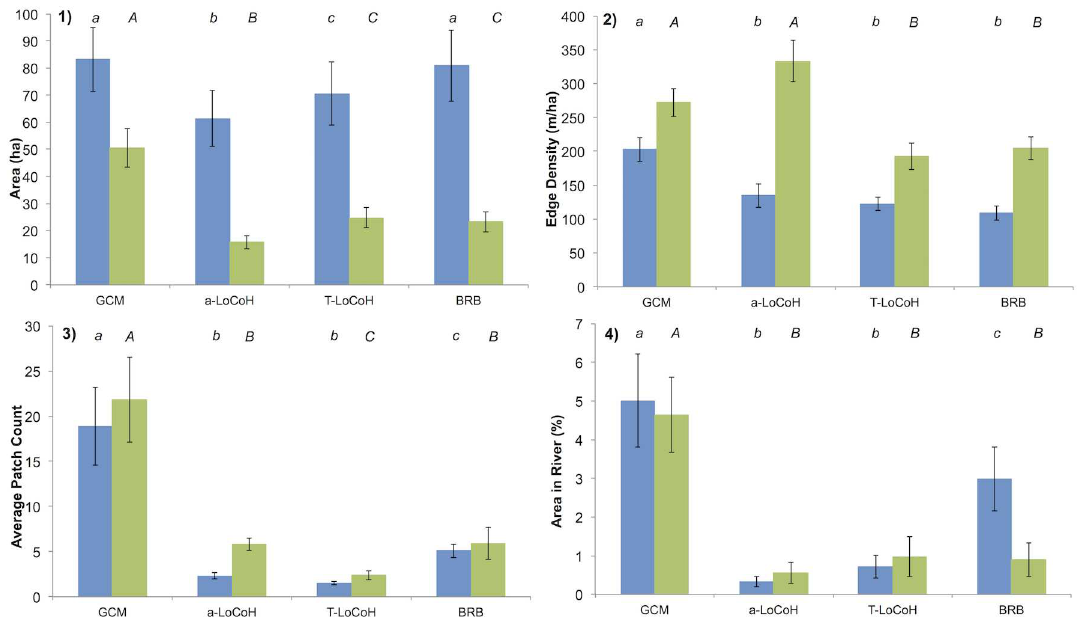
Fig 4. Summary of averagesfor overall (90%, blue) and core (50%, green) home range comparison variables (N = 10 individuals). (1) home range area; (2) boundarycomplexity (edge density); (3) patchinessand (4) barrier detectionfor: Grid- cell method (GCM), adaptivelocal convex hull ( a -LoCoH), adaptivetime local convex hull (T-LoCoH). a,b,c Pair-wise results from Tukey test; results significantly different from another (p < 0.05)are indicatedby a different letter, those with the same letter showedno significant difference. Lower-case letters represent overall home range differences, and upper-case letters representcore-rangedifferences.